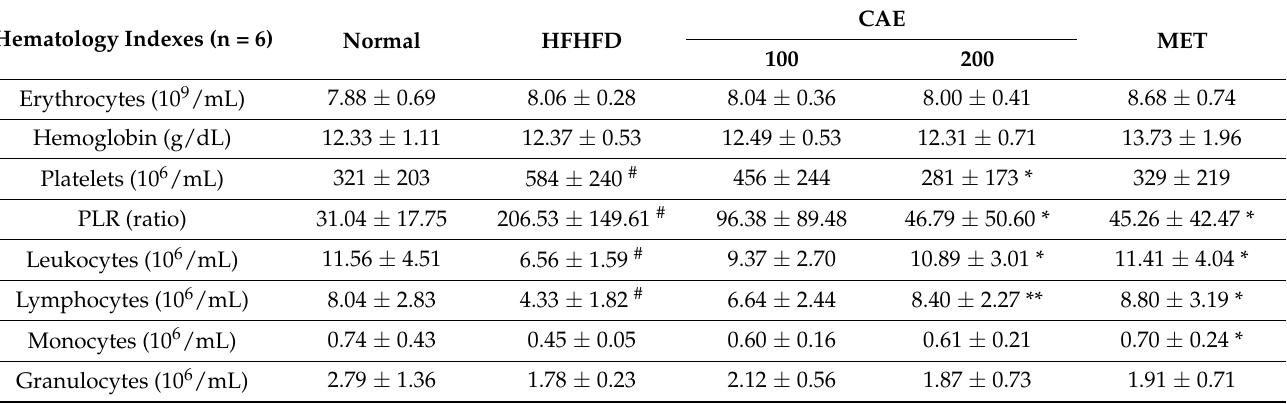
Table 2. Analysis of cell blood